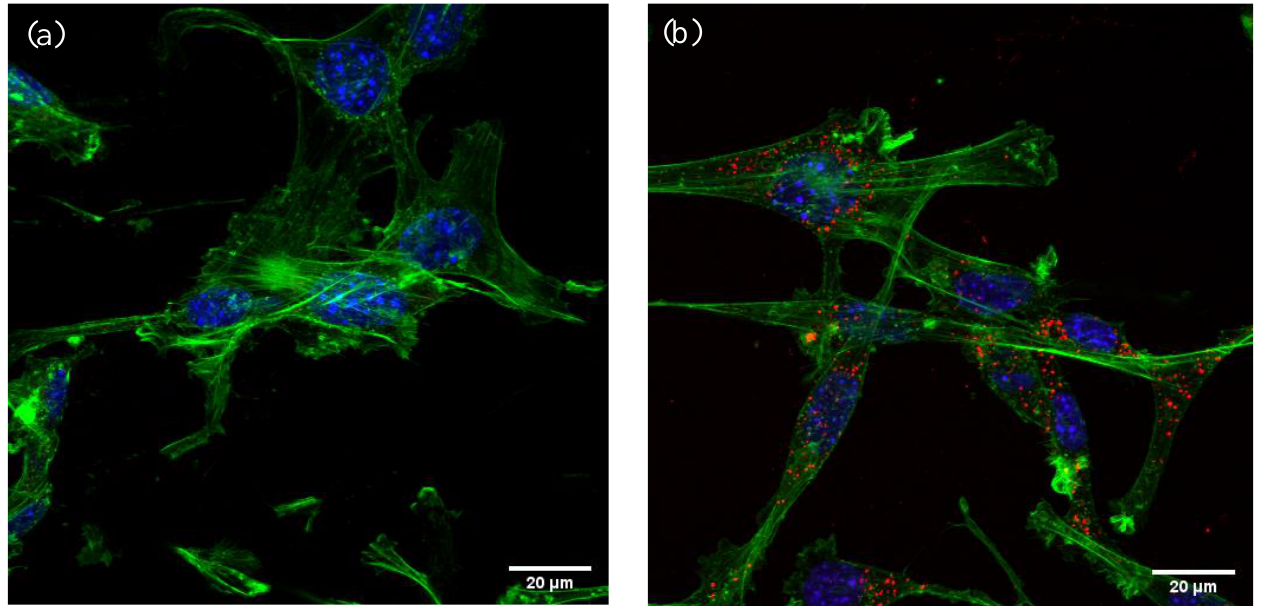
Figure 10. Confocal microscope images of MSCs dosed with ( a ) NV-40 and ( b ) NV-90 NDs. MSCs were seeded in chamber slides (2 × 10 5 cells/well) and left to grow and adhere for 24 h, before dosing with 100 µg/ml NDs for a further 24 h. Cells were fixed with 4% PFA and stained with DAPI (blue) and AlexaFluor ® 488 (green); NV NDs are displayed in red.